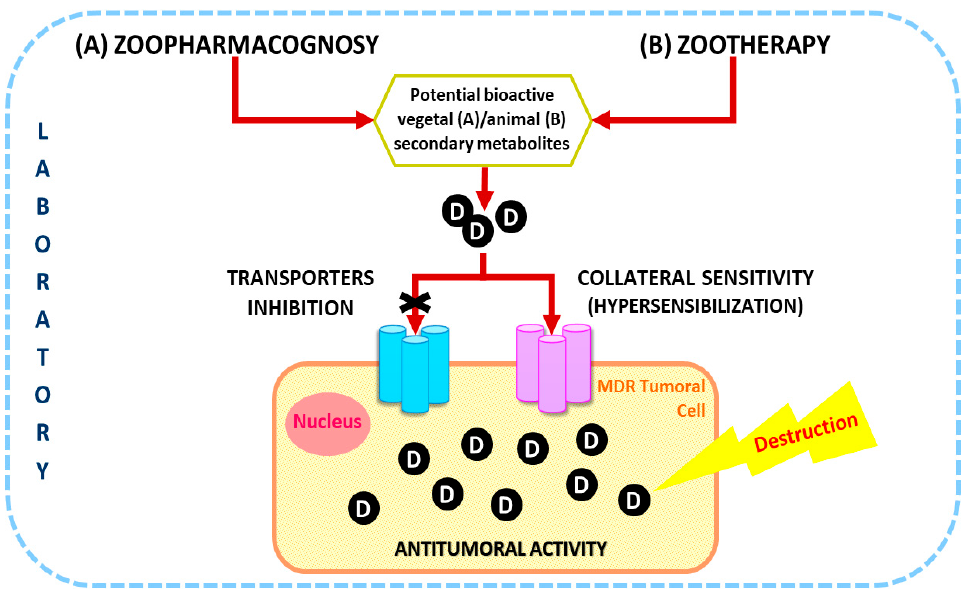
Figure 2. Scheme explains how the bioactive compounds provided by Zoopharmacognosy and Zootherapy drug development strategies can overcome MDR. The strategies involve the inhibition of transporters that expel the drugs and the hypersensitization of cancer-resistant cells. Abbreviation: D, Drug; MDR, MultiDrug Resistance.